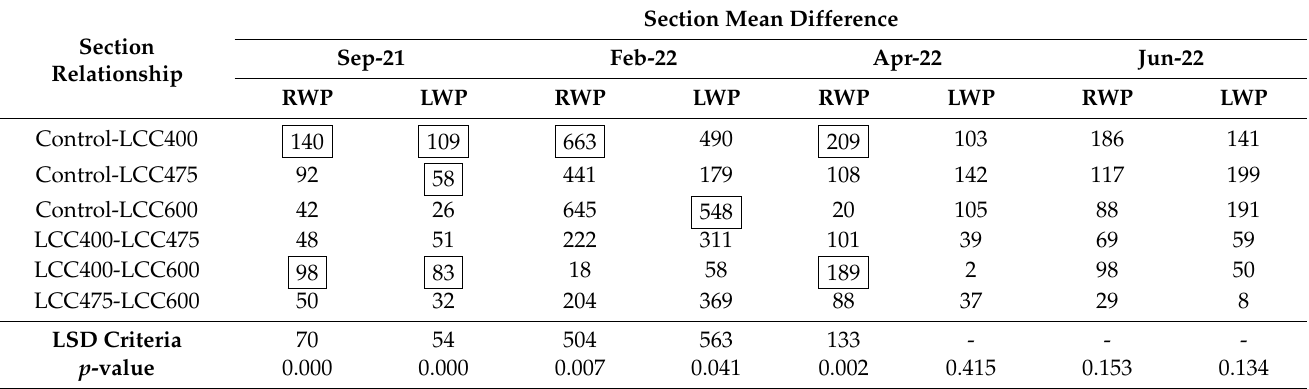
Table 2. Notre Dame Drive mean least square difference (LSD)